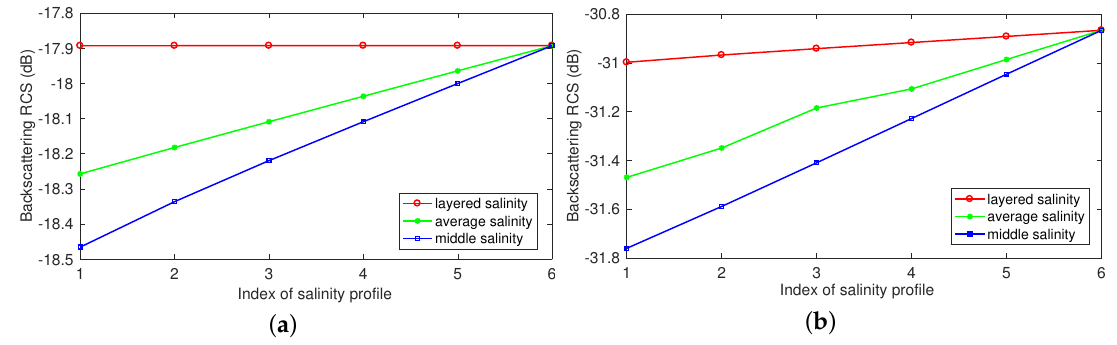
Figure 12. Backscattering RCS of HH polarization for six different salinity profiles at ( a ) C-band and ( b ) L-band. The results using the assumption that sea ice is a homogeneous medium with a constant salinity are also plotted by using the average salinity of the profile and the salinity in the middle of the sea